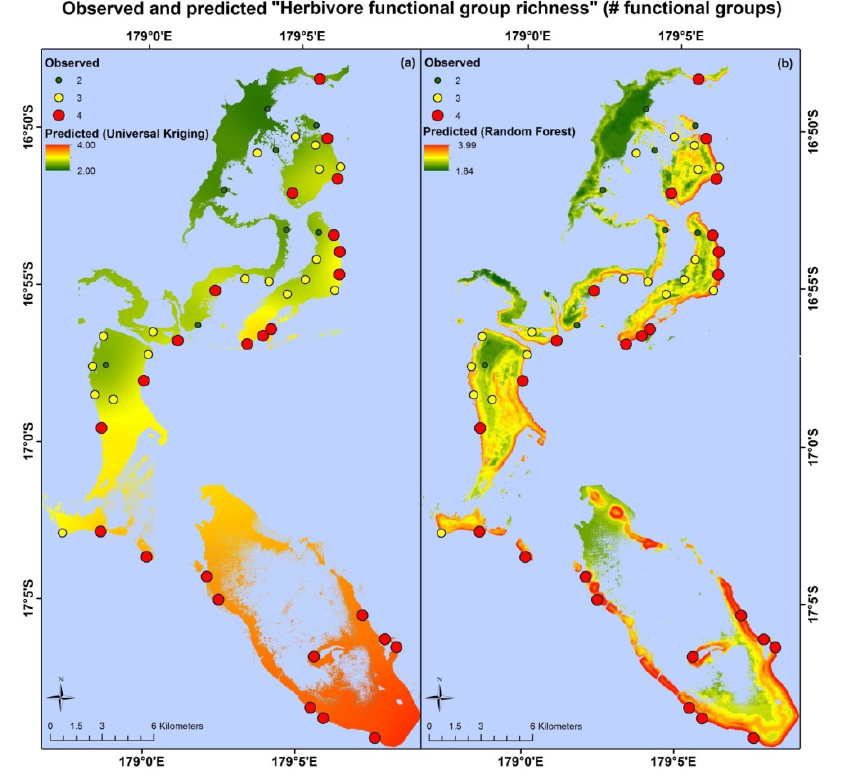
Figure 3. Observed and predicted values of “herbivore functional group richness” for the study area. ( a ) Predictions based on the Universal Kriging model. ( b ) Predictions based on the Random Forest